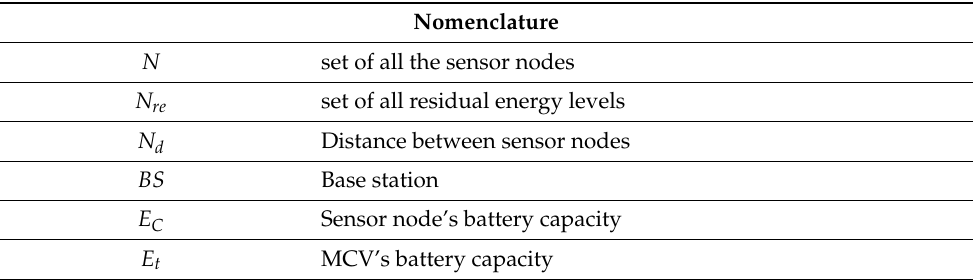
Table 1. Symbols and